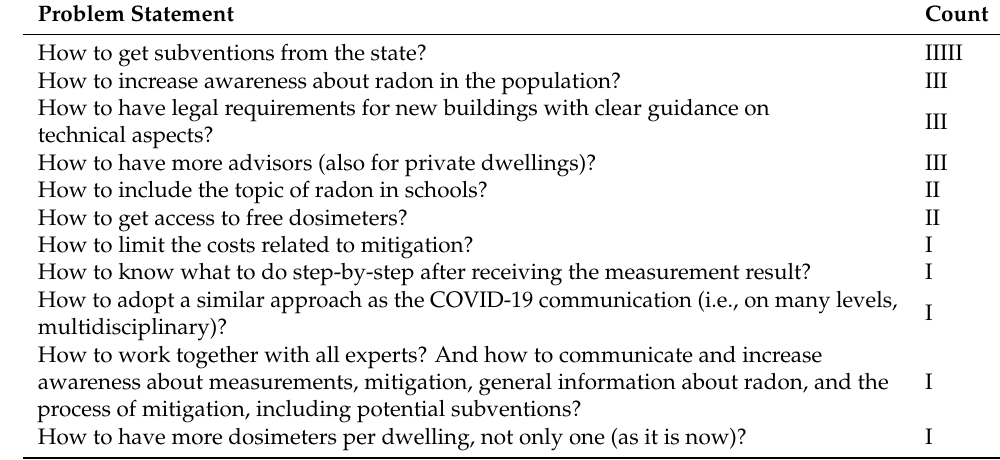
Table 3. Slovenia: problem statements—converging.